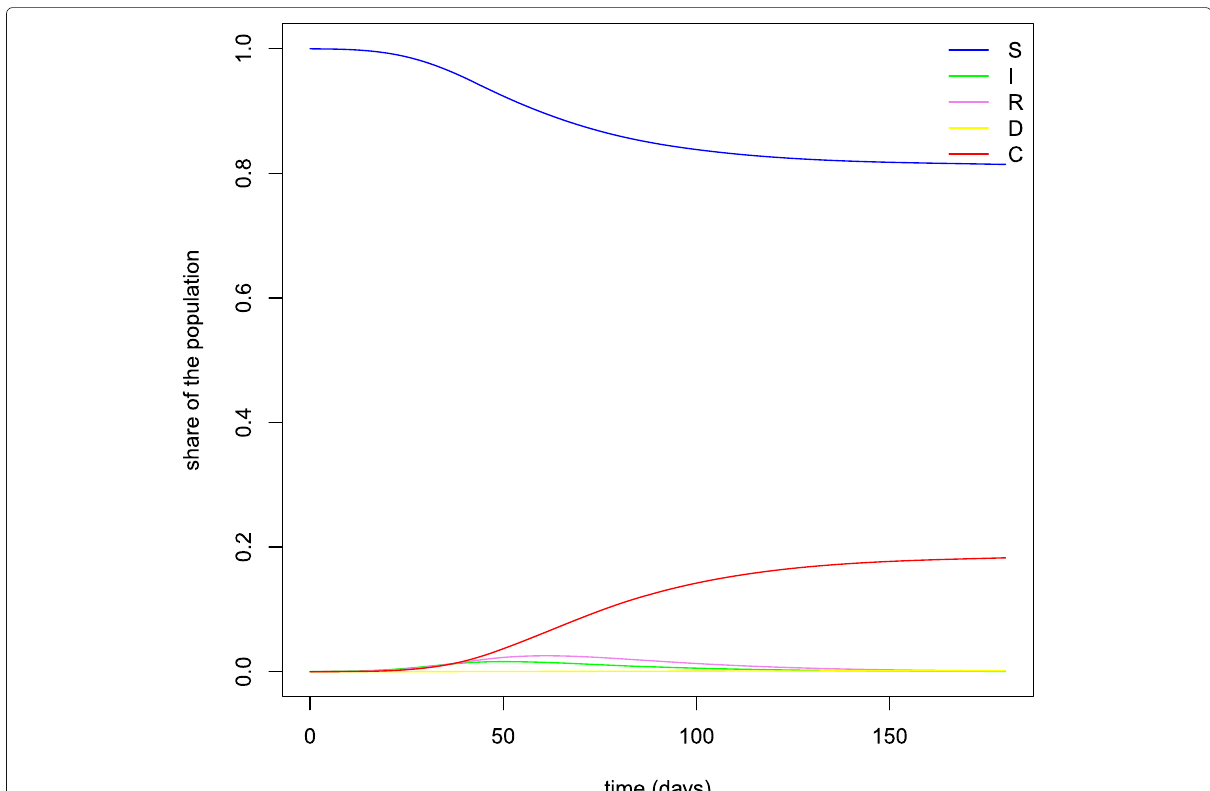
Fig. 3 SIRDC model. Note: This figure plots the evolution of the daily shares of individuals in each compartment according to the predictions of our SIRDC model over the time period considered